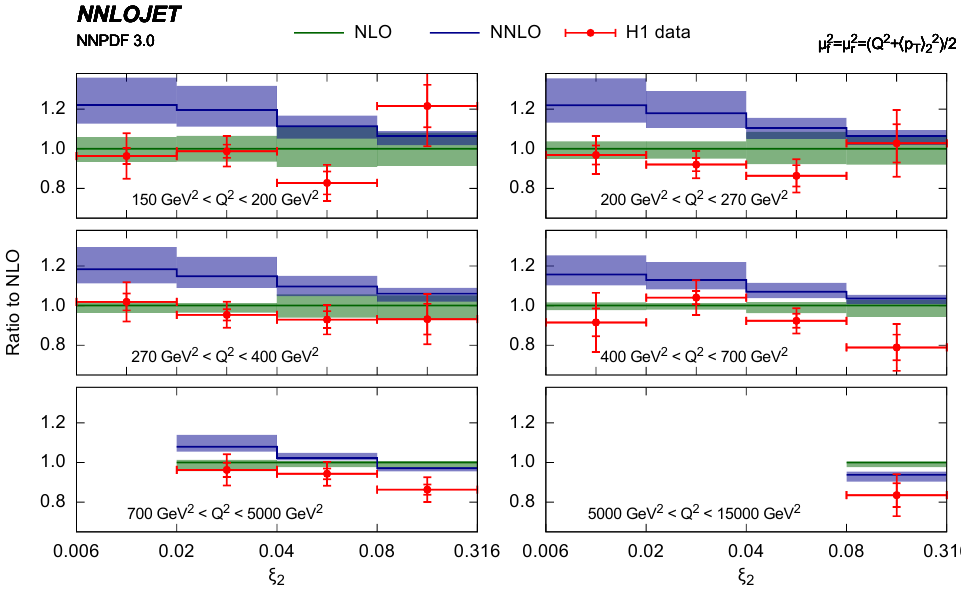
Figure 15 . Inclusive di-jet production cross section as a function of (cid:24) 2 in bins of Q 2 , compared to H1 high- Q 2 data.